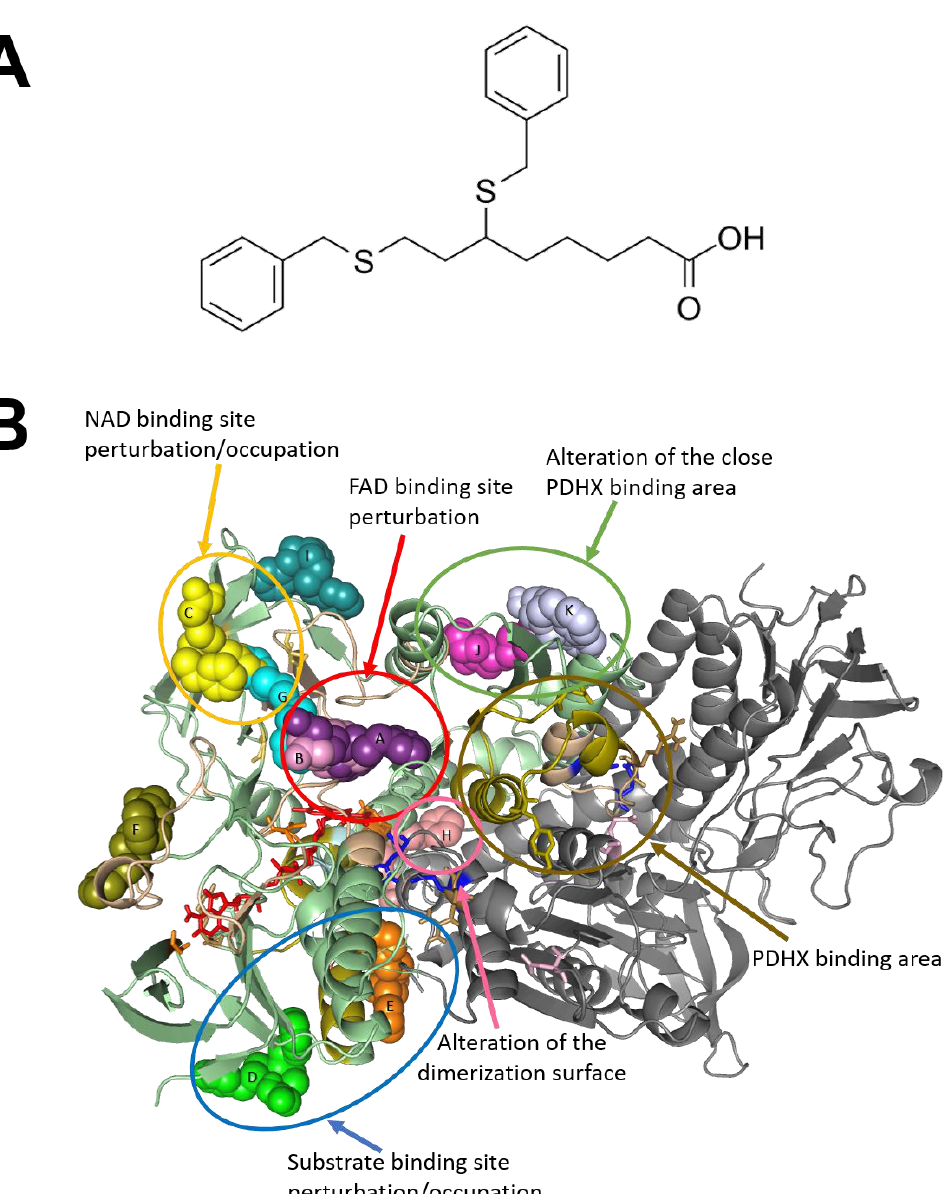
Figure 4. Docking simulations of the interaction of CPI-613 with human DLD. ( A ) The chemical structure of CPI-613, an analogue of α -lipoic acid that inhibits DLD enzyme and targets tumor mitochondrial energy metabolism. ( B ) Pockets detected by docking simulations of the interactions between CPI-613 and human DLD; different circles correspond to different perturbation areas relevant for DLD activity: in spheres, CPI-613 bonded to different sites of human DLD in green (chain A) and grey (chain B). The different positions of CPI-613 are labelled with letters (A to K).